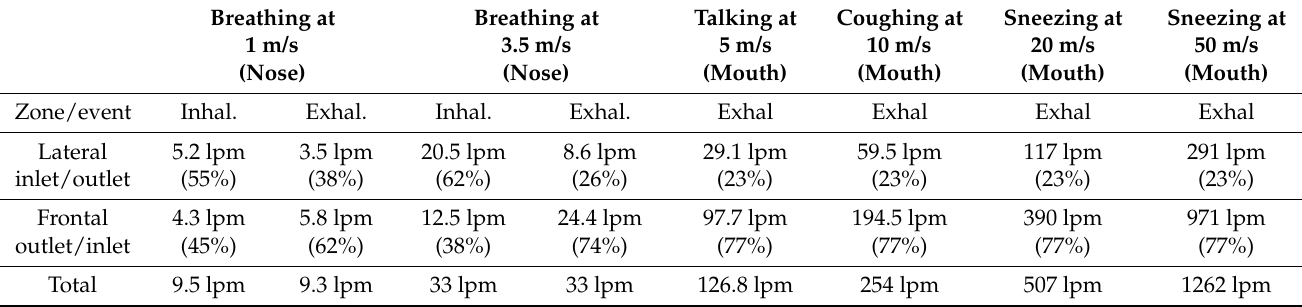
Table 4. Air flow and percentages per zone and event for masks with valves and without filters at boundaries. Breathing